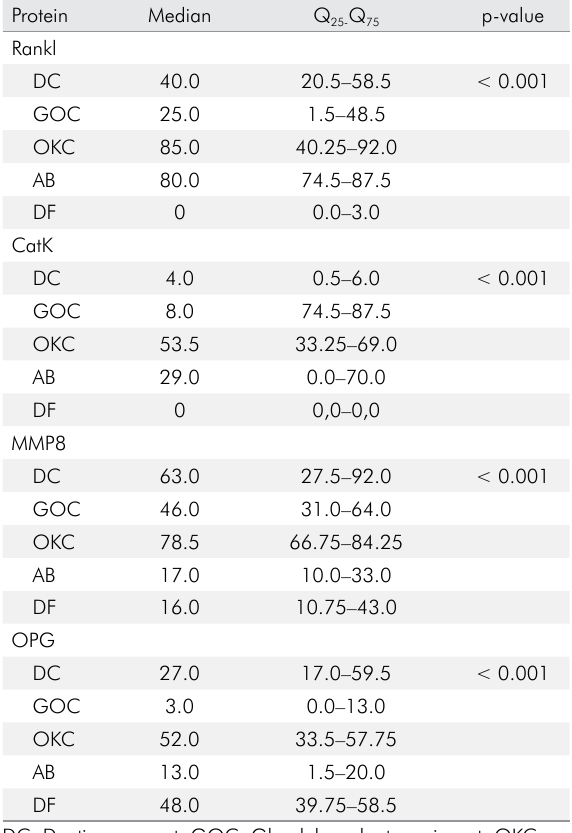
Table 2. Comparison of immunohistochemical expression of the studied proteins in connective tissue in dentigerous cyst, glandular odontogenic cyst, odontogenic keratocyst, ameloblastoma, and dental